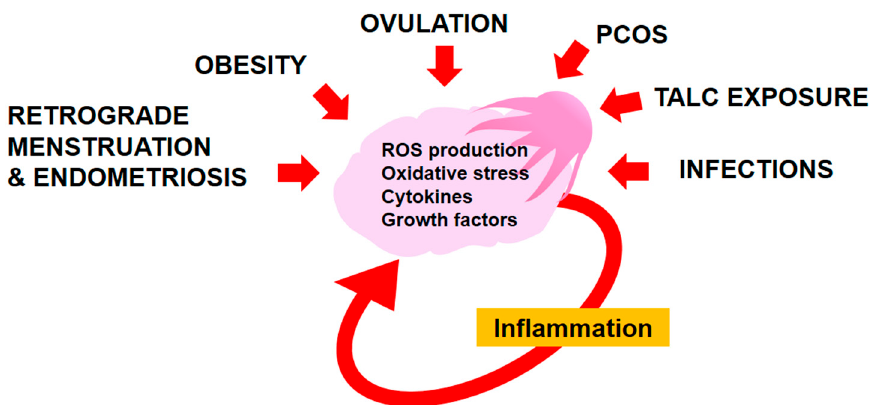
Figure 1. Sources of inflammation in the ovary and fimbriae. Ovulation, retrograde menstruation, endometriosis, infections, exposure to talc, Polycystic Ovarian Syndrome (PCOS), and obesity result in exposure of the ovary and fimbriae to reactive oxygen species (ROS), oxidative stress, cytokines, and growth factors, generating an inflammatory response that leads to additional production of ROS and cytokines in the ovary. Unresolved, chronic inflammation is a critical risk factor for tumor initiation.